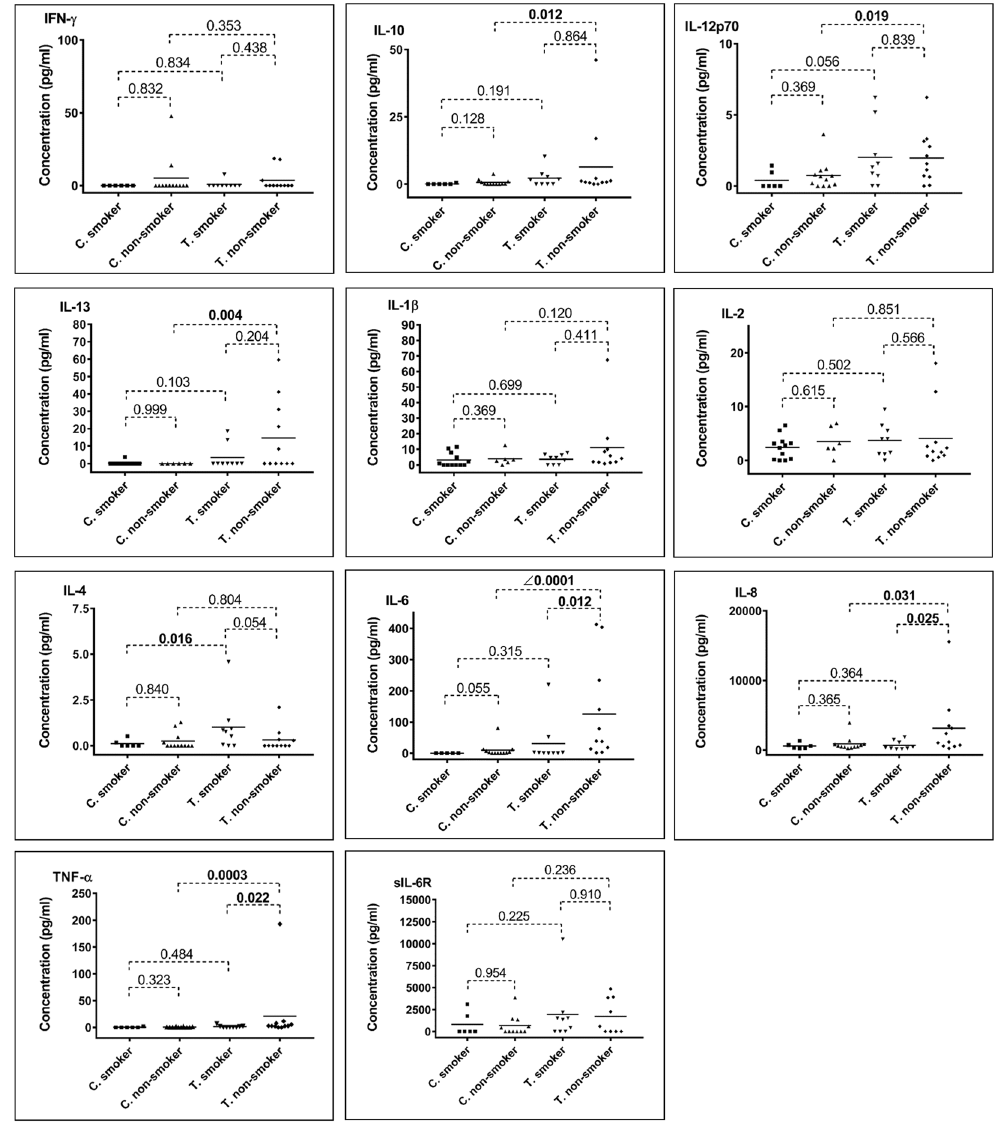
Figure 4. Cytokine concentrations (pg/ml) in tears of TAO patients (T) and control subjects (C), comparing subgroups of smokers and non-smokers. * Mann-Whitney U tests, p-values (bold data highlight significant